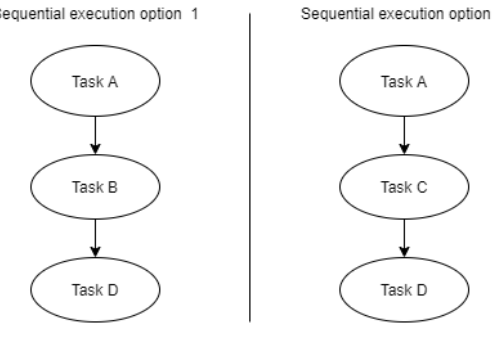
Figure 9. Tracking options for the tasks of Figure 8.